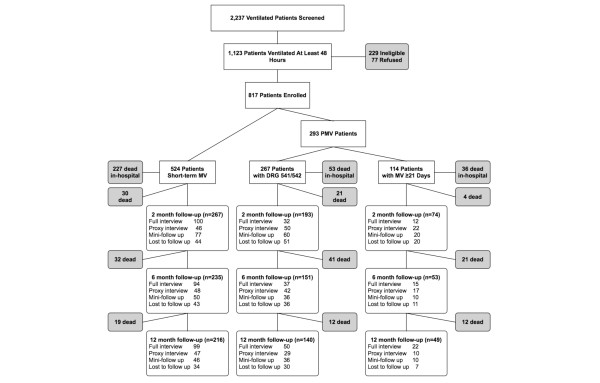
Flowchart of participants in the study by DRG 541/542 status. Diagram demonstrates enrollment of 817 patients into this prospective study. DRG, diagnosis related group.